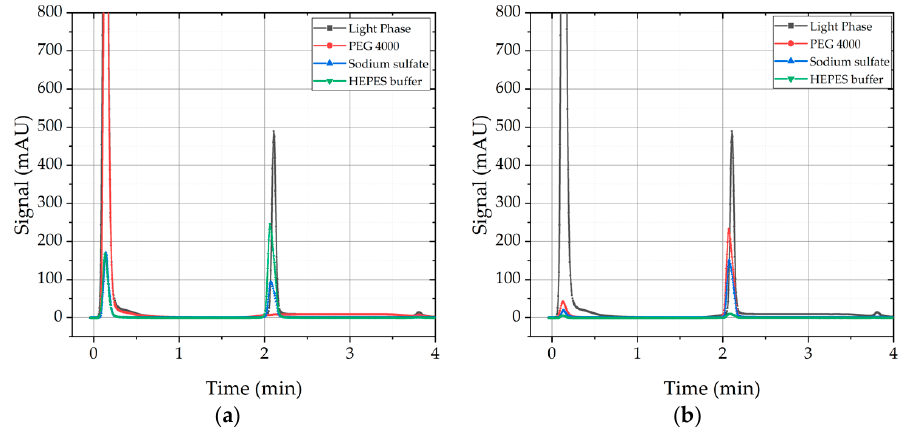
Figure 8. Results of the washing solution screening. ( a ) Waste after wash. Samples that were washed with sodium sulfate and HEPES buffer show re ‐ dissolved mAb in waste. PEG 4000 solution does not. ( b ) Re ‐ dissolved mAb in sodium dihydrogen phosphate/disodium phosphate buffer (pH = 5; 50 mM).